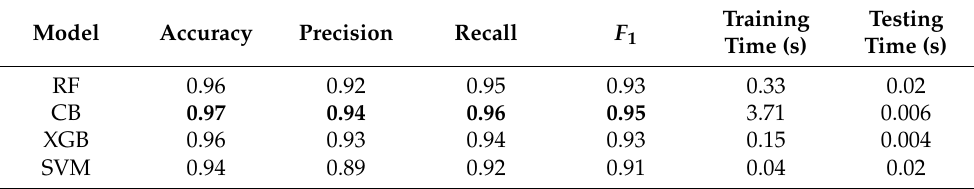
Table 3. Model performance for seagrass detection in Tauranga Harbour for the 2019 dataset. Model